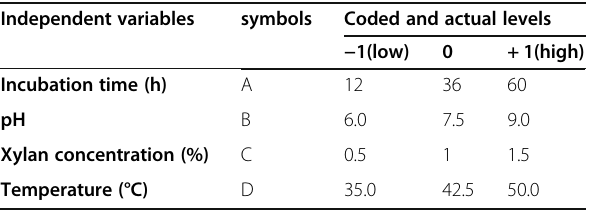
Table 1 Actual levels for the four variables Box-Behnken design in response surface methodology of the xylanase enzyme extracted from the bacterium Pseudomonas mohnii Independent variables symbols Coded and actual